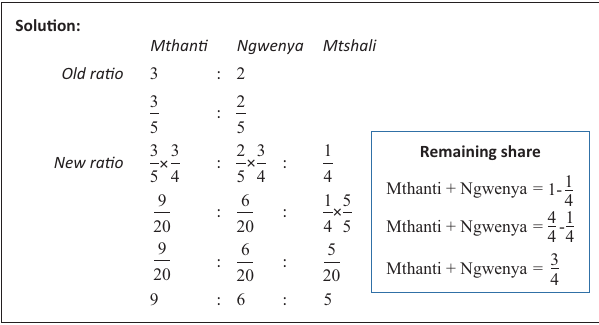
FIGURE 9: New profit sharing ratio. From third-year BEd Accounting.